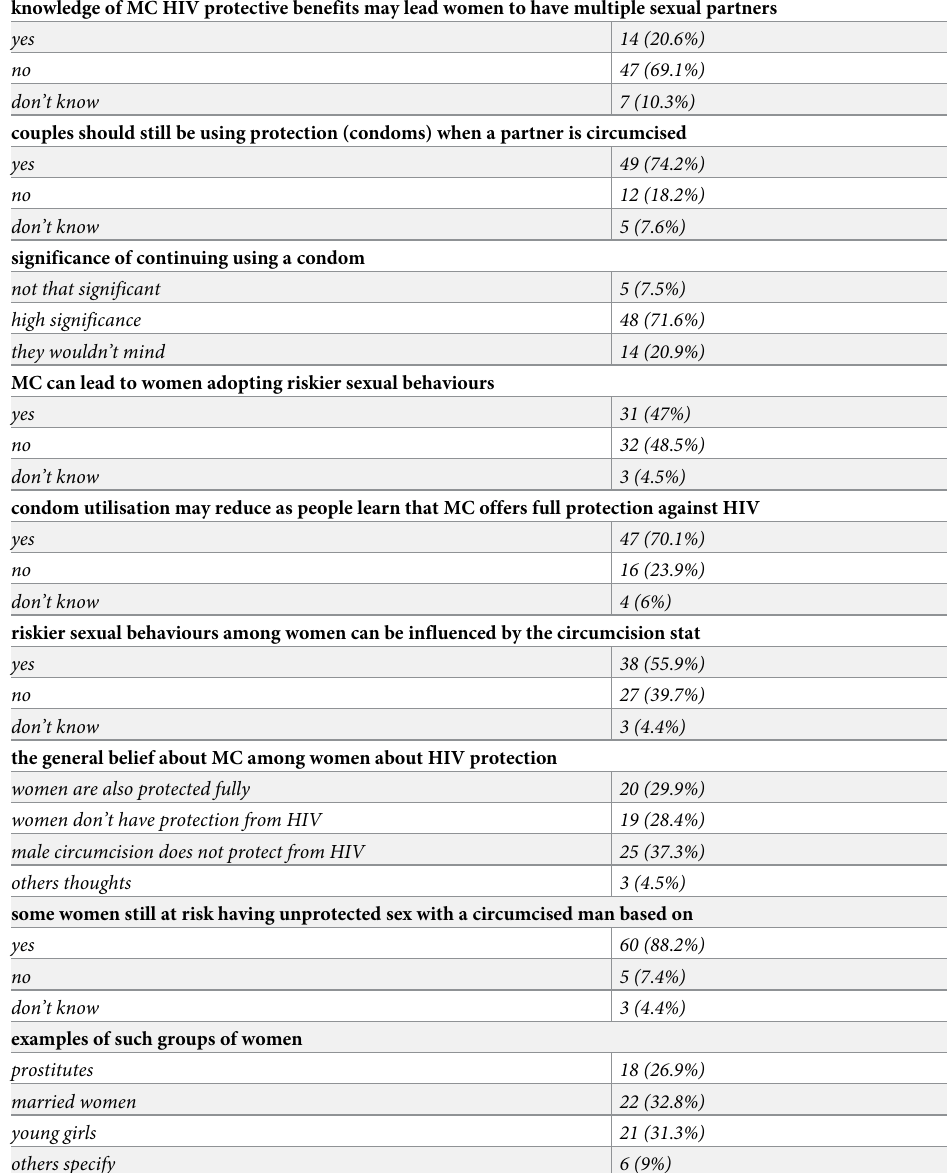
Table 6. Summary descriptive analysis of current perceptions on risk compensation. knowledge of MC HIV protective benefits may lead women to have multiple sexual